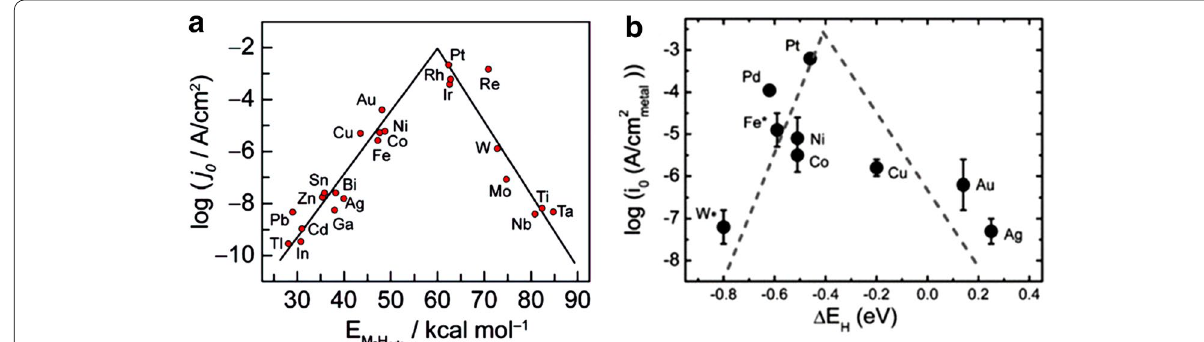
Fig. 3 Volcano plots: a exchange current density vs. the M–H bond energy for each metal surface (for acidic media) (Figure reprinted with permission from Refs. [32, 33]); b exchange current density on monometallic surfaces vs. the calculated HBE (for alkaline media) (Figure reprinted with permission from Ref.